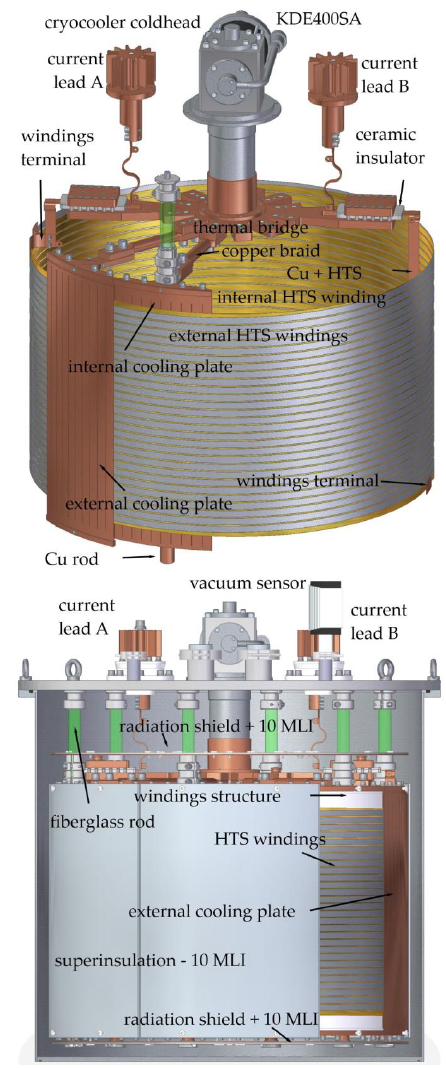
Figure 2. HTS windings construction and cross-section of SFCL